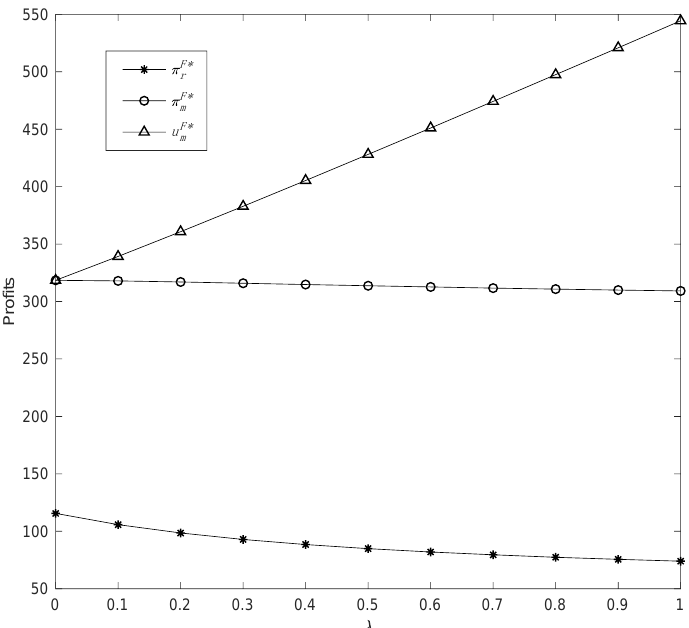
Figure 6. The change in profits with parameter λ.